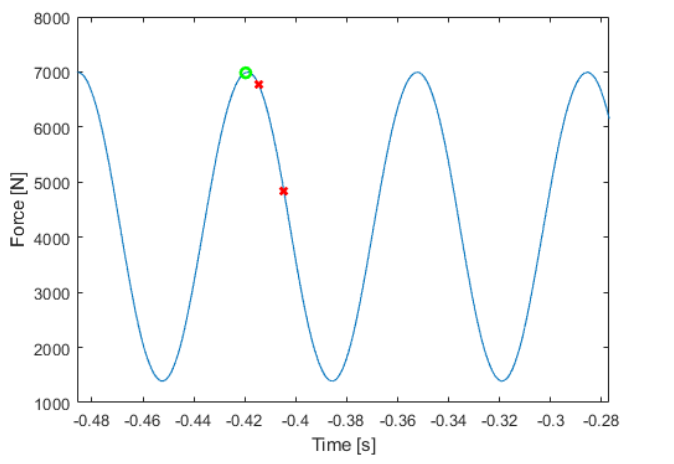
Figure 10. Load signal, and region used to determine crack tip position.